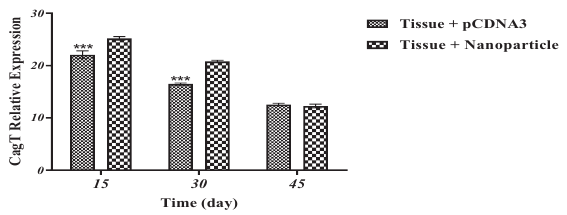
Figure 7. The comparison of the cagT gene expression in injected groups by pcDNA3.1(+)- cagT and pcDNA3.1(+)- cagT + nanoparticle at different times after the last injection.